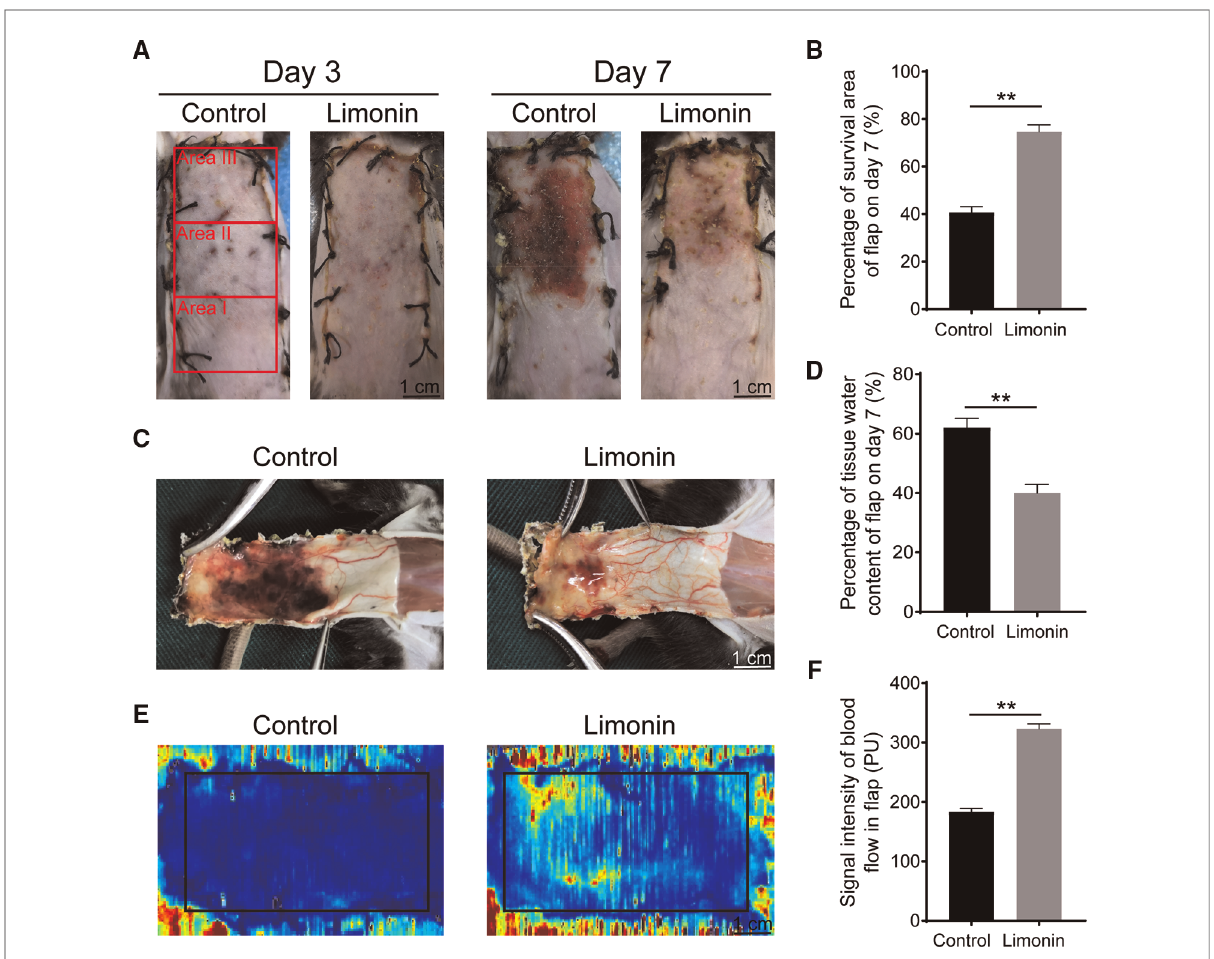
FIGURE 1 Limonin elevated the survival of random skin fl aps. ( A ) Digital photographs of macroscopic surface of postoperative fl aps on days 3 and 7 post- surgery (scale bar, 1 cm). ( B ) Histogram about percentage survival of random skin fl aps on days 7 post-surgery. ( C ) Digital photographs of inner face of skin fl aps, showing tissue edema and vessel statin of fl aps. ( D ) Histogram about the percentage of tissue water content on days 7 post- surgery. ( E ) Visualization of blood fl ow below the tissue surface measured by LDBFI. ( F ) Histogram of blood fl ow on days 7 post-surgery. Data are mean±standard error of the mean, n =6 per group. ** P <0.01, vs. control group. LDBFI, Laser Doppler blood fl ow